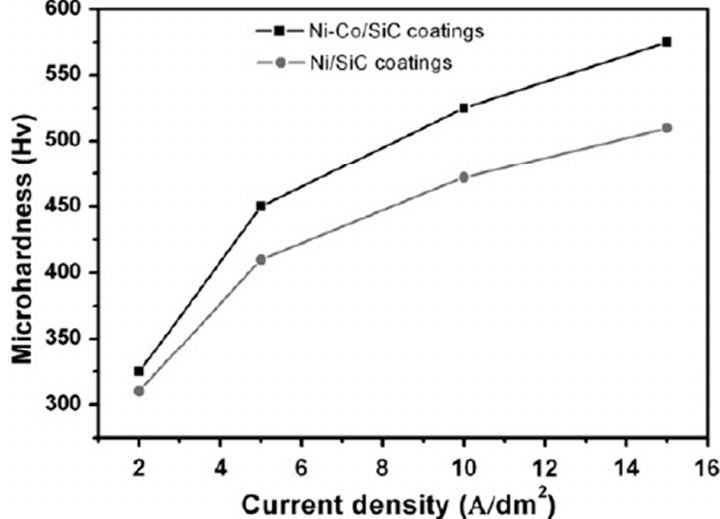
Figure 9. The e ff ect of current density on microhardness of Ni–Co / SiC and Ni / SiC coatings Figure 9. The effect of current density on microhardness of Ni–Co/SiC and Ni/SiC coatings [115]. Reprinted from Surface and Coatings Technology, 206, S.M. Lari Baghal, M. Heydarzadeh Sohi, A.